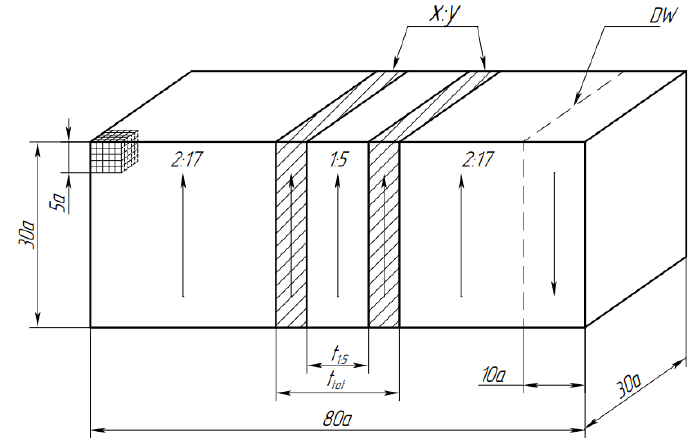
Figure 1. Schematic diagram of the initial magnetization state of the micromagnetic model containing two 2:17 phase cells and complex (x:y/1:5/x:y) cell boundary, where x:y = 2:7 or 5:19, and showing the existence of magnetic 180 ◦ domain wall inside the right 2:17 cell before applying an external magnetic induction (field); DW is the domain wall; t is the width; and a = 1 nm.